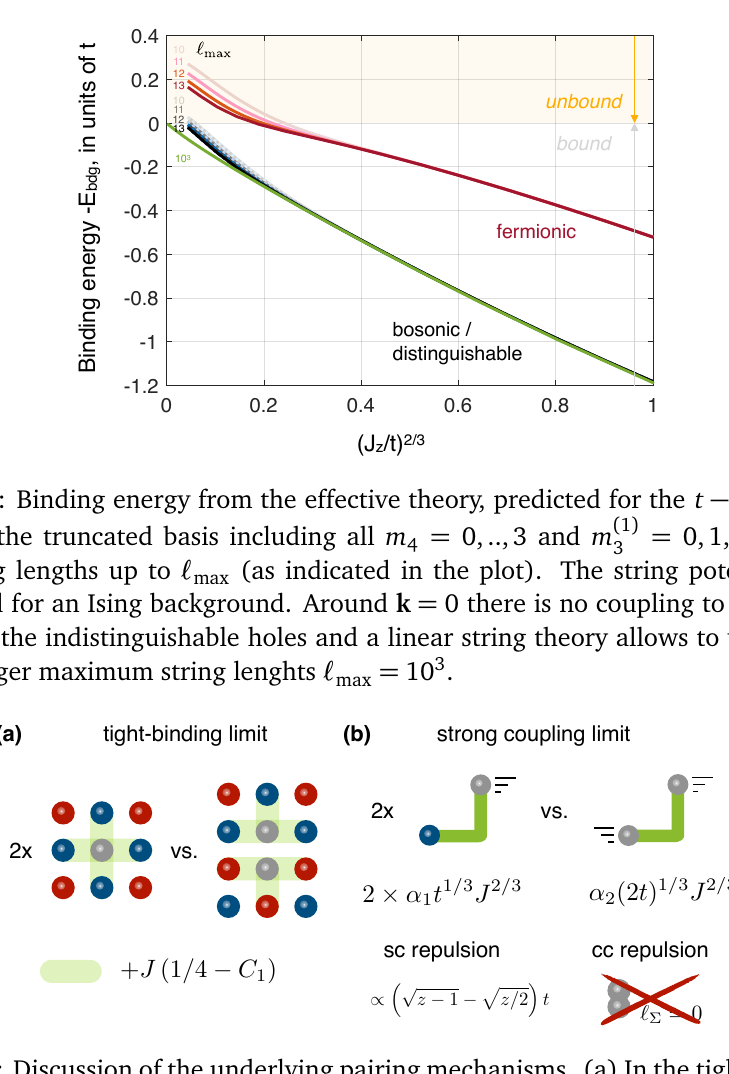
Figure 12: Discussion of the underlying pairing mechanisms. (a) In the tight-binding ≫ t , kinetic contributions can be ignored. In this case the distortion of limit J ( z ) the Néel background can be minimized while also gaining maximal energy from the nearest-neighbor attraction term in the t − J ( model. (b) In the strong coupling z ) limit the hole’s kinetic energy dominates, leading to a powerful pairing mechanism when one hole retraces the string of the other. This mechanism is supported by an effective spinon-chargon (sc) repulsion with a geometric origin [ 29 ] and suppressed by the hard-core chargon-chargon (cc)